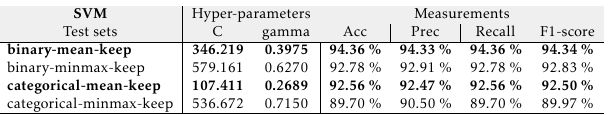
Table 5. Best binary and categorical classifiers modeled with SVM.